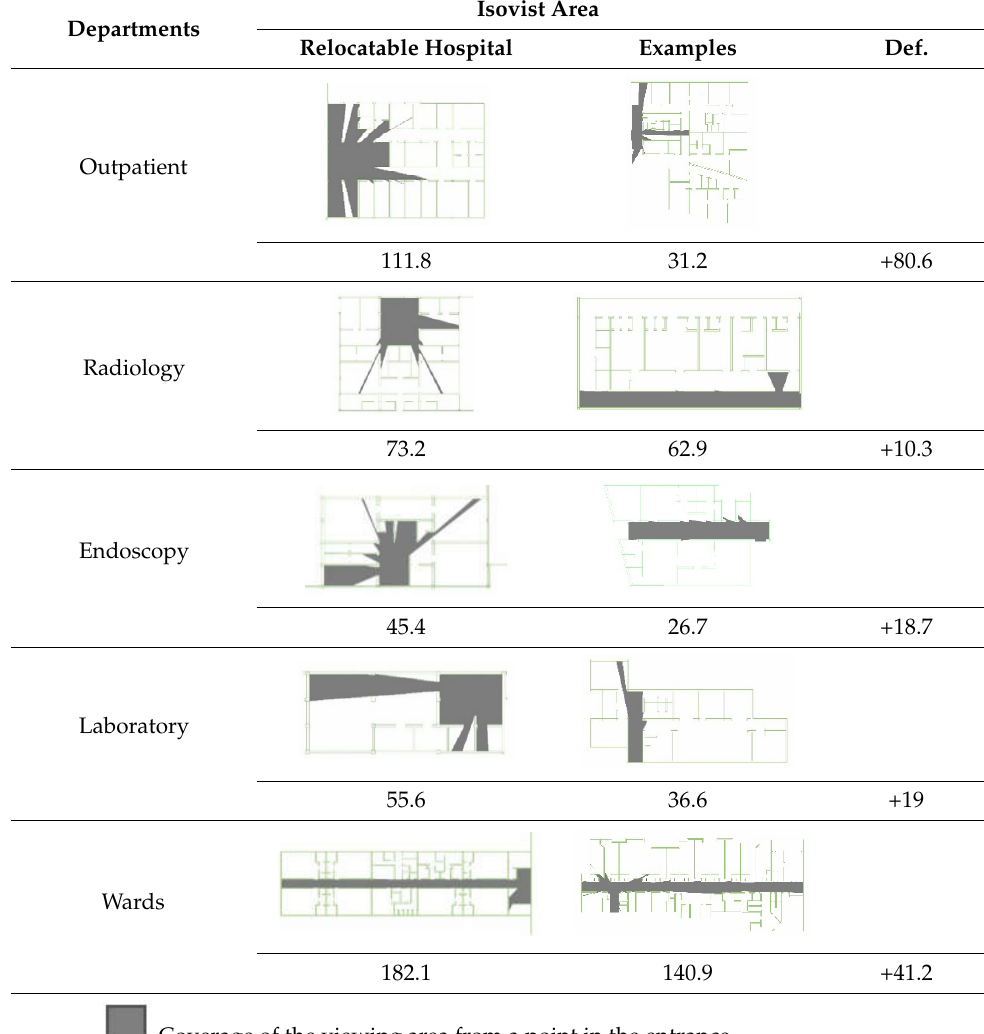
Table 13. Axial Map/Integration values and the graphs of case study departments compared to examples.